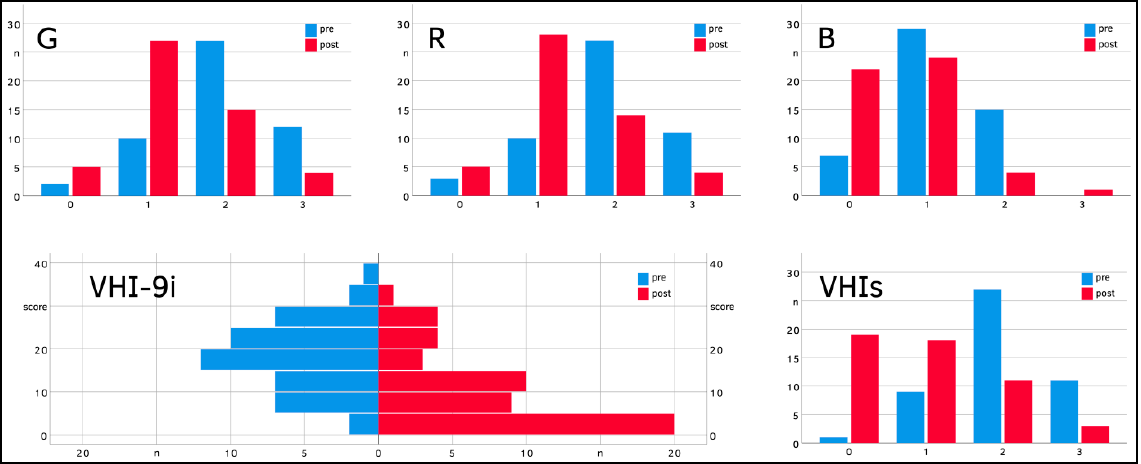
Figure 3. Subjective vocal parameters before and after pT1a removal. Upper row: Comparison of pre- and postoperative voice parameters according to the GRB-classification. Lower row: Comparison of pre- and postoperative VHI-9i and VHIs scores.